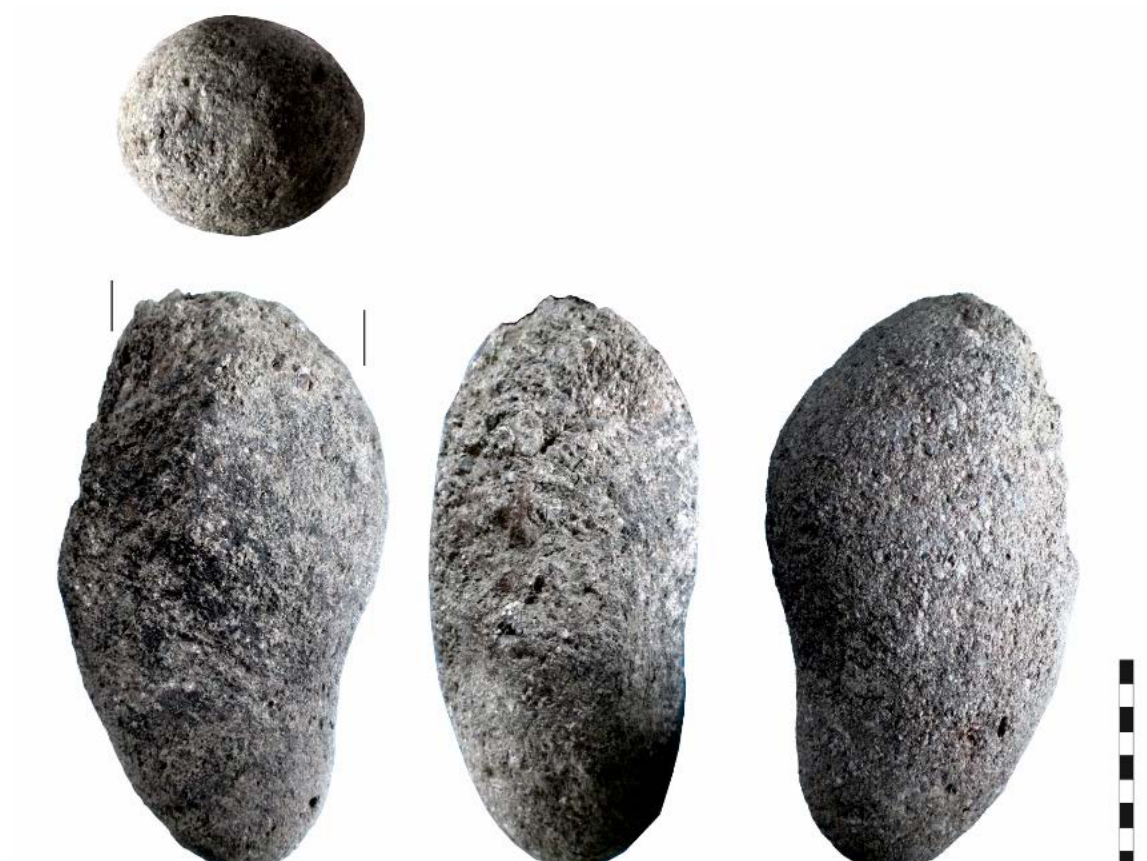
Figure 7. Grinder redesigned through flaking in order to be used as a pounder. Active end (top) and various faces (scale in